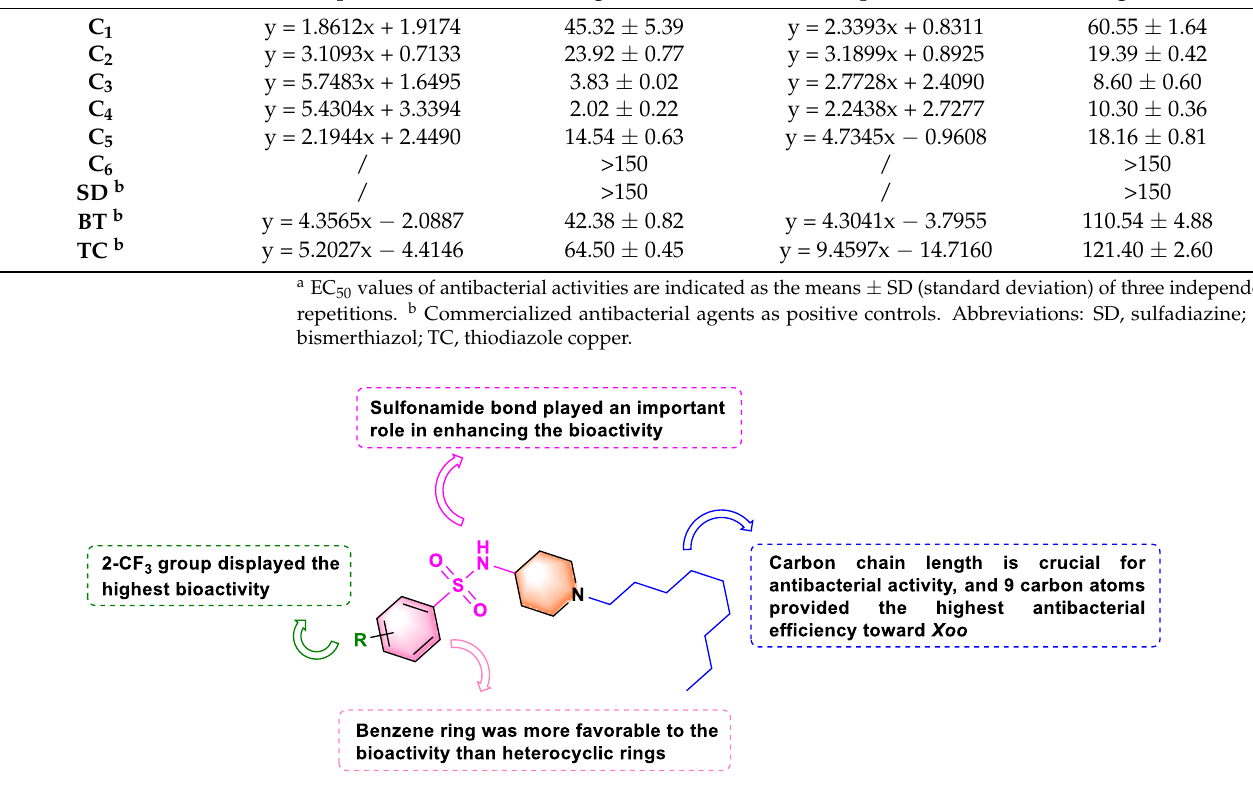
Table 3. In vitro antibacterial activities of target molecules C 1 − C 6 against plant pathogens.